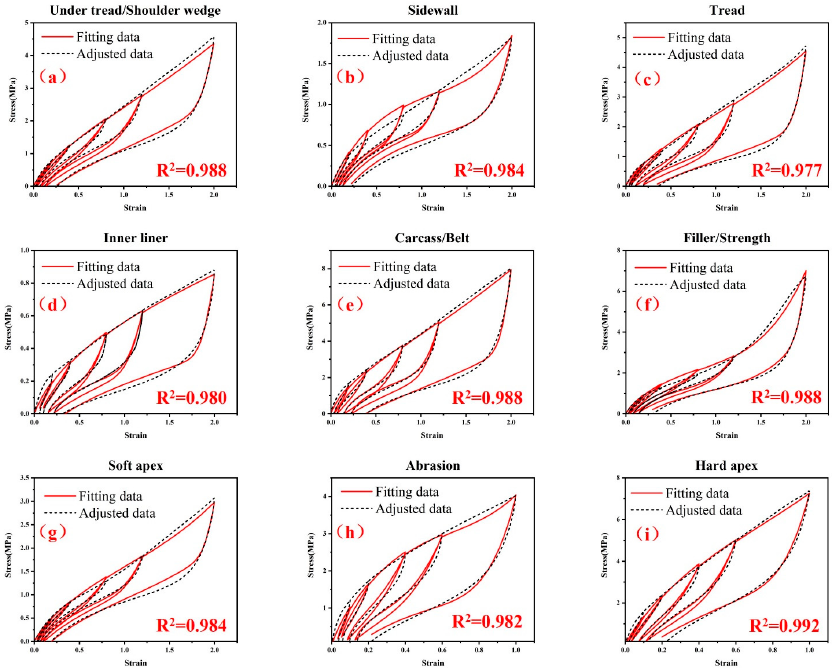
Figure 10. Comparison between the adjusted stress–strain data and the fitting results using the final optimized material parameters of the hyper-pseudo-viscoelastic constitutive model for the nine rubber materials in TBR tires: ( a ) under tread and shoulder wedge, ( b ) sidewall, ( c ) tread, ( d ) inner liner, ( e ) carcass rubber and belt rubber, ( f ) filler rubber and strength rubber, ( g ) soft apex, ( h ) abrasion and ( i ) hard apex.